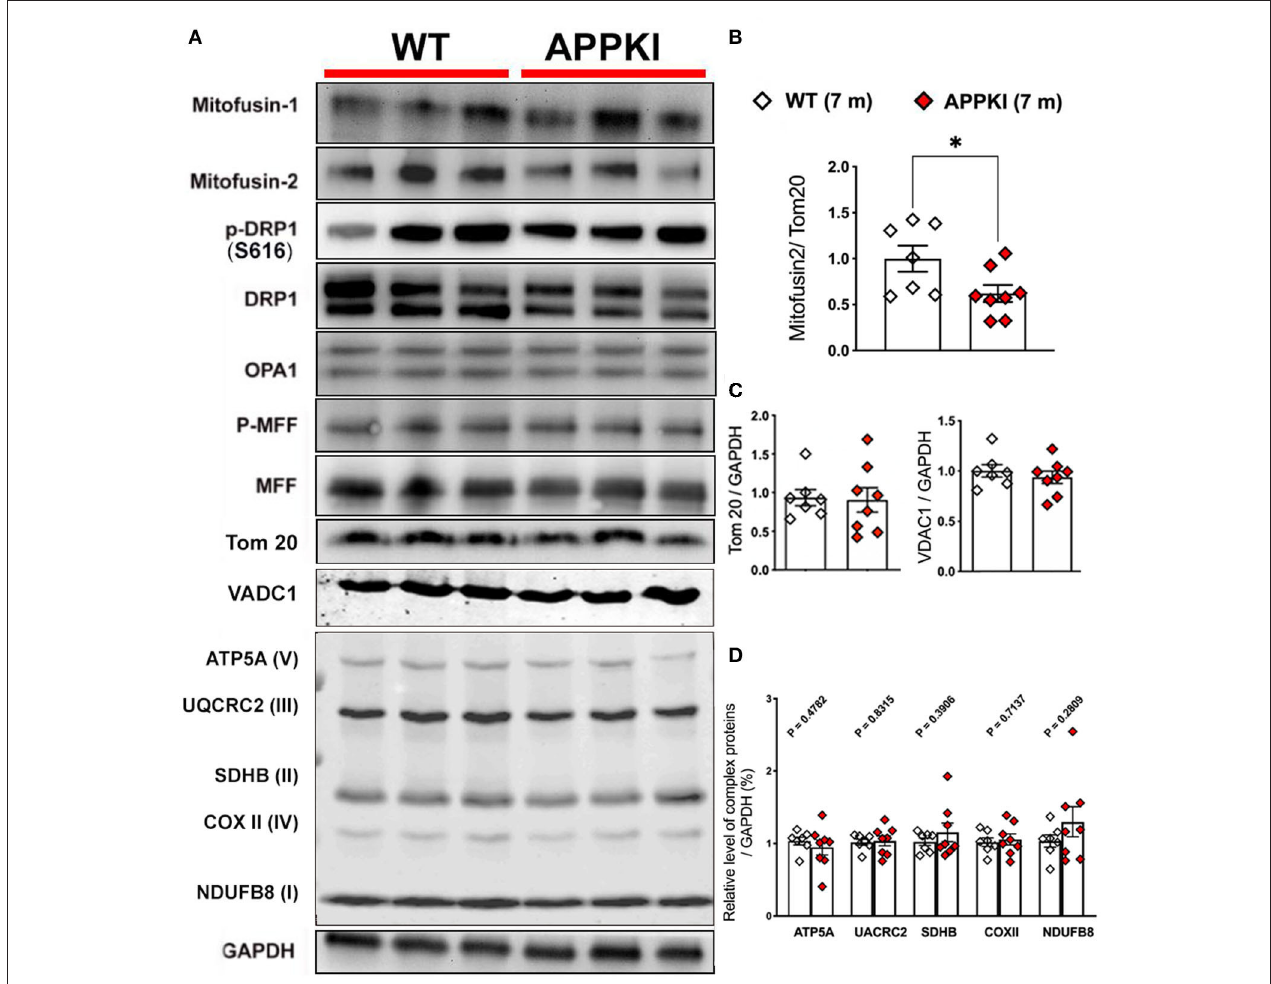
FIGURE 7 | Decreased MFN2 in 7-m APPKI mice brain. (A) Representative blots of hippocampal homogenates from 7-m APPKI mice. (B) Densitometry analysis of MFN2 expression. Tom 20 was used as a loading control for all the mitochondrial dynamic proteins. (C,D) Densitometry analysis of Tom 20, VDAC1, and mitochondrial complex I–V expression. GAPDH was used as a loading control for (C,D) . Data are presented as mean ± SEM; n = 7–8 mice per group. Data were analyzed using Student’s t -test, and significance was assumed when p < 0.05. * p <